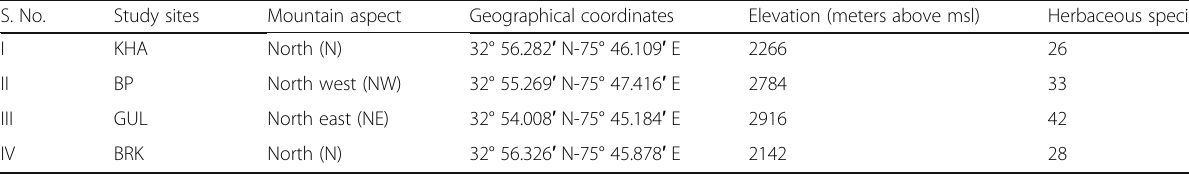
Table 1 Details of study sites in Lesser Himalayan stratum S.